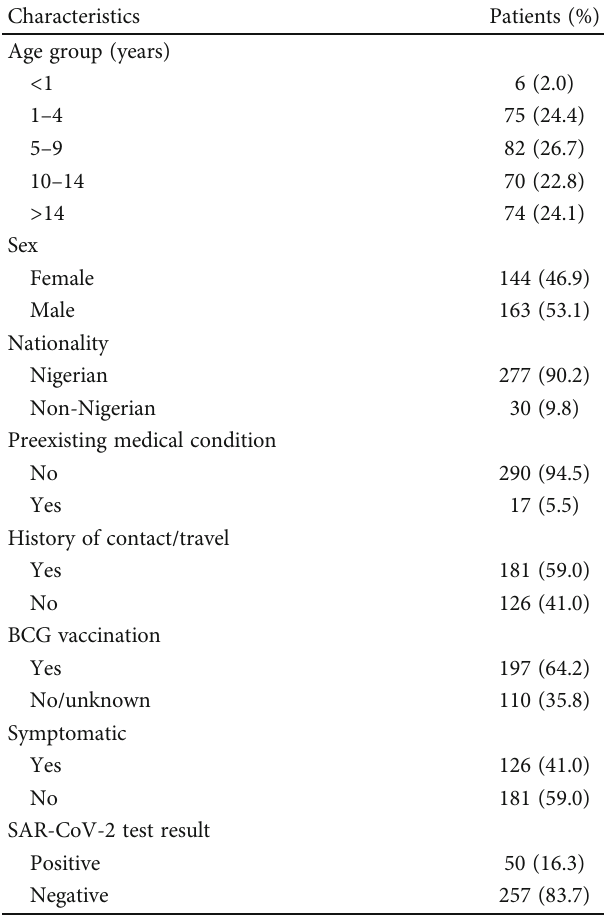
Figure 2: Pattern of children screened and Table 1: Characteristics of the children screened for SARS-CoV-2 infection.